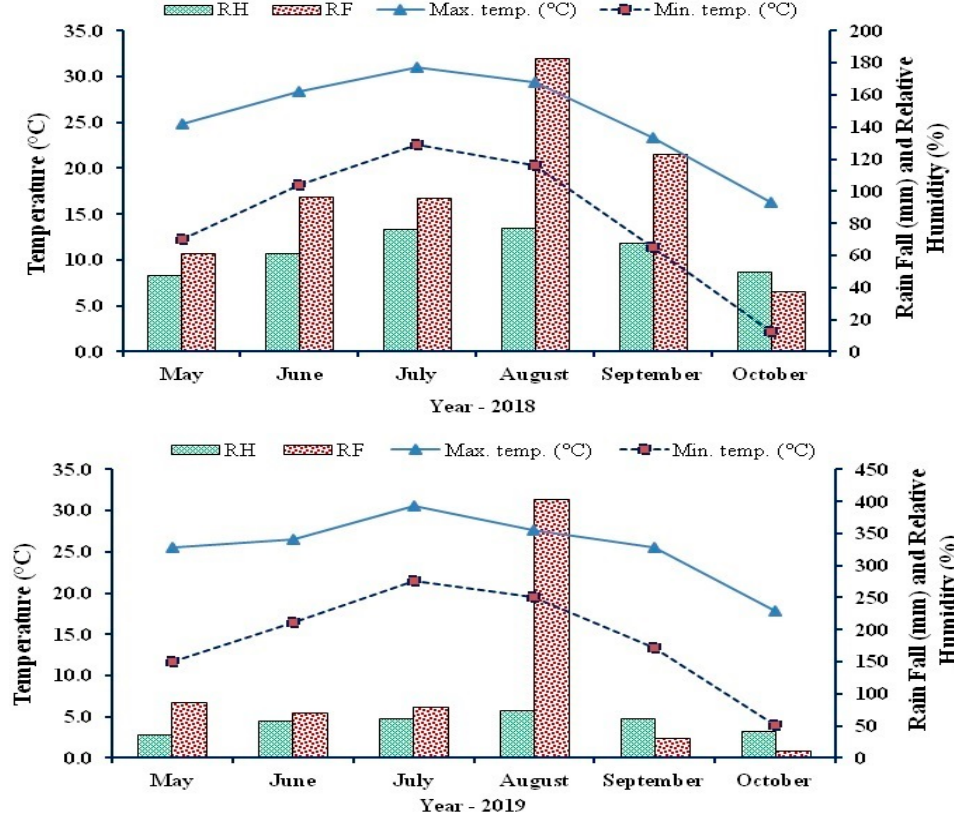
Figure 1. Metrological data of experimental site during the years of 2018 and 2019.